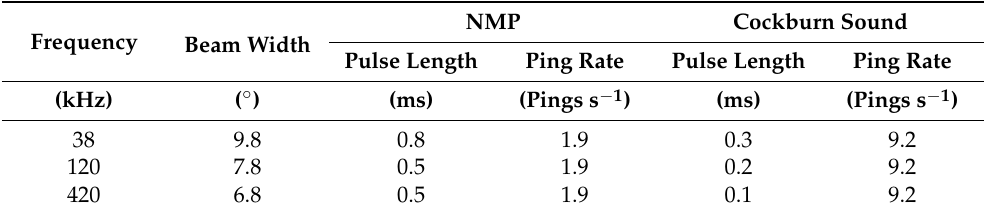
Table 1. Settings of the transducers mounted in the pontoon for the two areas included in the study. NMP Cockburn Sound Frequency Beam Width Pulse Length Ping Rate Pulse